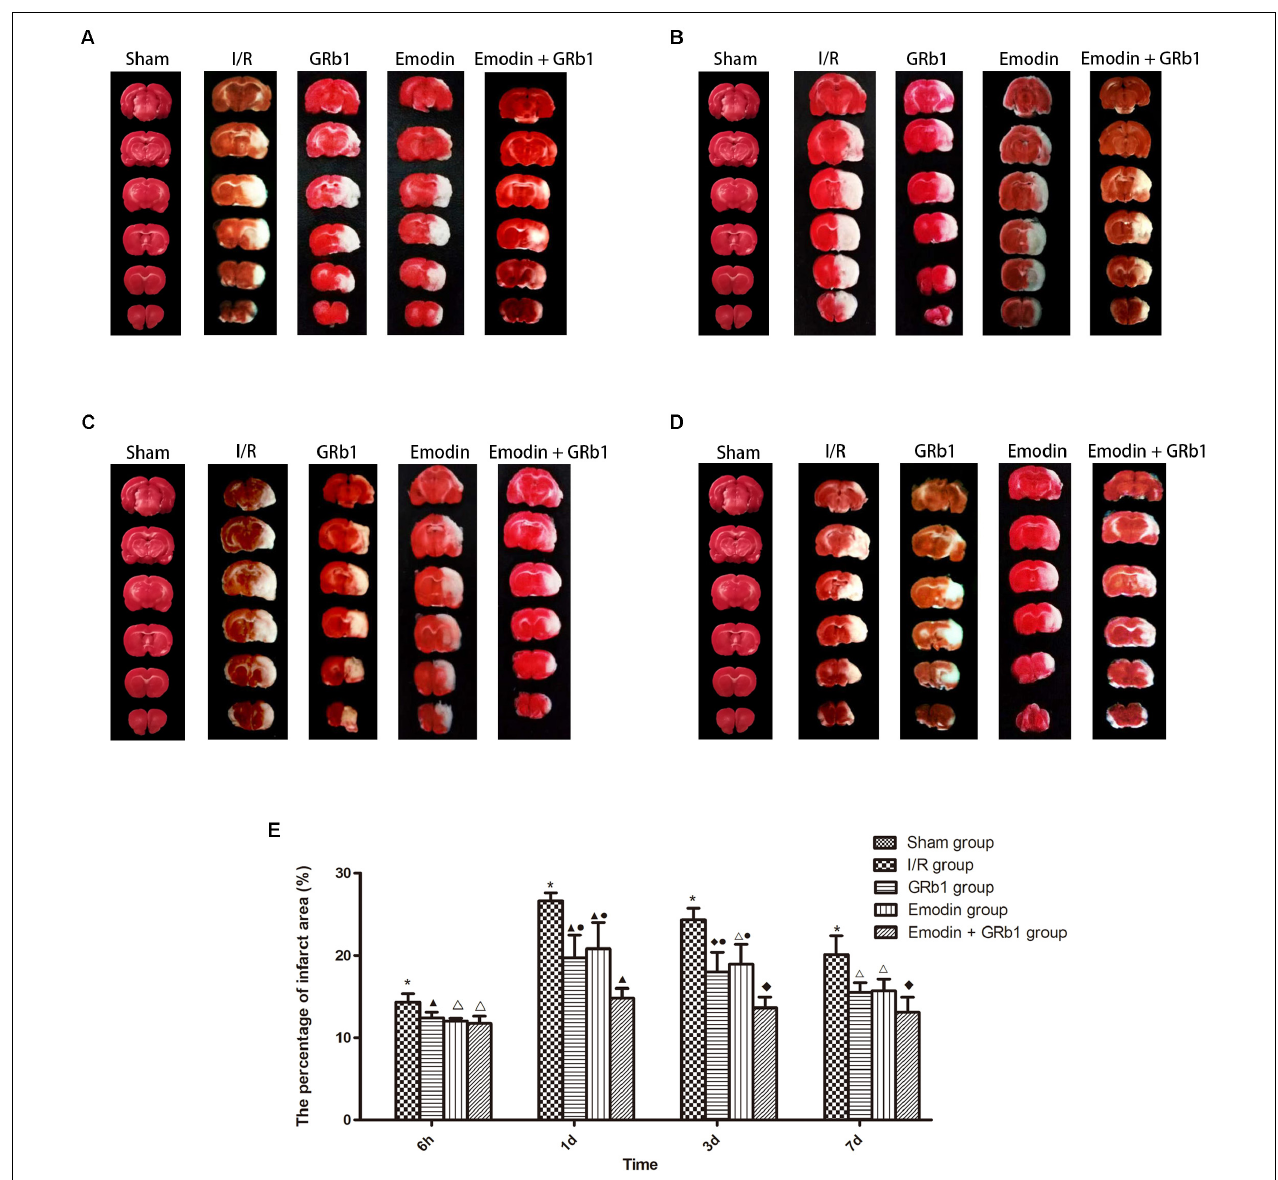
FIGURE 3 | The percentage of infarct area in different groups after I/R in rats (mean ± SD, n = 5). TTC staining was used to evaluate cerebral infarction area after I/R in rats in four sub-groups at (A) 6h, (B) 1d, (C) 3d, and (D) 7d. (E) Quantitative analysis for the results of (A–D) . One-way analysis of variance (ANOVA) was used for multiple group experiments comparisons and followed by Dunnett test for comparison of two groups within the multiple groups. ∗ p < 0.001, compared with Sham group. (cid:78) p < 0.05, (cid:77) p < 0.01, (cid:7) p < 0.001, compared with I/R group. • p < 0.01, compared with the Emodin+GRb1 group.